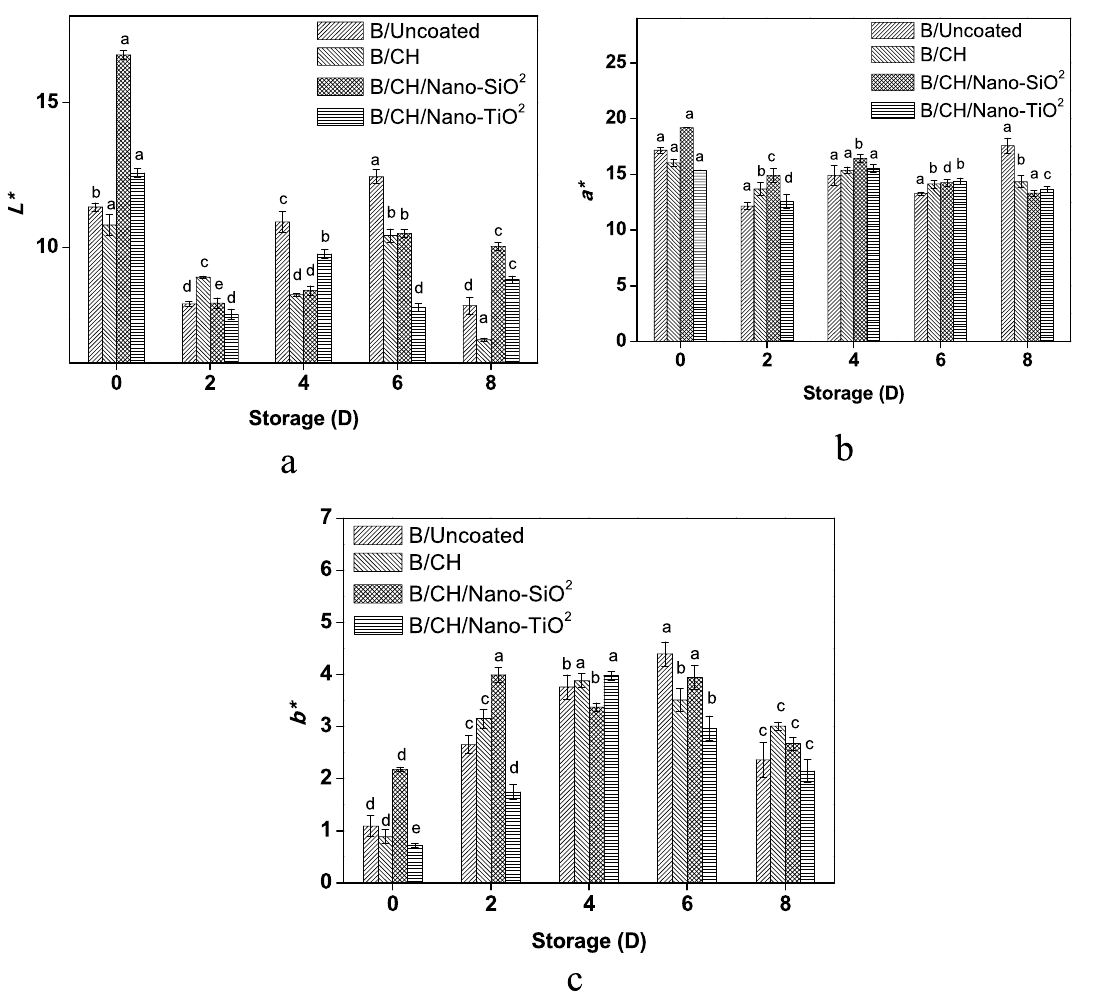
Figure 3. Effects of coating films on colour index L * ( a ), a * ( b ) and b * ( c